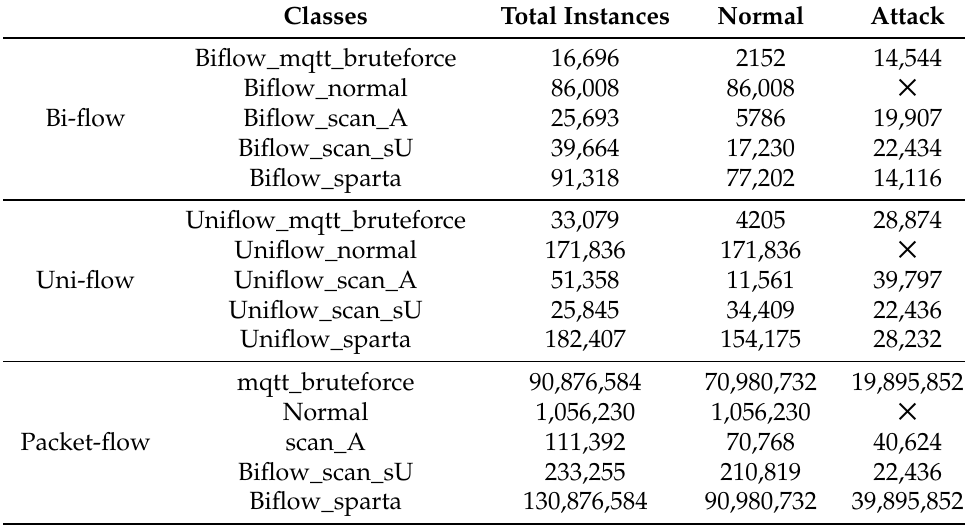
Table 4. Three abstract-level feature statistics of MQTT-IoT-IDS2020.